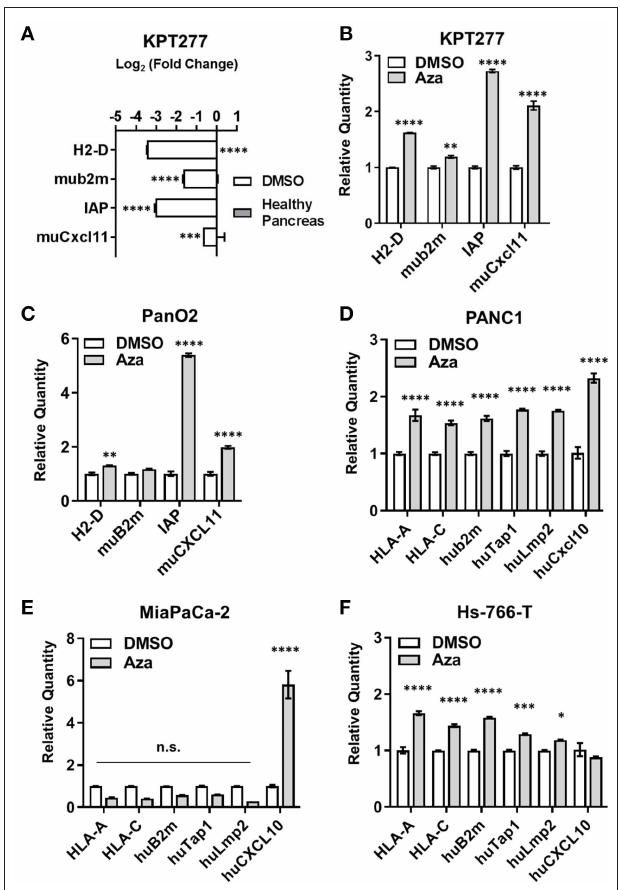
FIGURE 3 | Aza treatment augments antigen presentation- and T cell recruitment-related gene expression in mouse and human PDAC cells. qRT-PCR was performed on total RNA to assess gene expression for (A) KPT277 cells treated with DMSO for 96h in vitro vs. healthy pancreas from a C57Bl/6 mouse, and (B) KPT277 cells treated in vitro with DMSO or 10 µ M Aza for 96h. (C) qRT-PCR for the mouse PDAC cell line Pan02 treated in vitro with DMSO or 5 µ M Aza. (D–F) Human PDAC cell lines treated in vitro with DMSO or Aza (100 µ M for PANC1; 10 µ M for MiaPaCa-2; and 50 µ M for Hs-766-T) for 96h. In (A) , bars represent Log base 2-fold change relative to “Healthy Pancreas.” n = 3 biological replicates. In (B) and (C–F) , bars represent quantity of transcripts relative to vehicle (DMSO) for each gene. n = 3 biological replicates. p -values were assessed by[[Inline Image]] two-way ANOVA followed by Sidak’s multiple comparisons test. * p < 0.05, ** p < 0.01, *** p < 0.001, **** p < 0.0001. n.s. = not